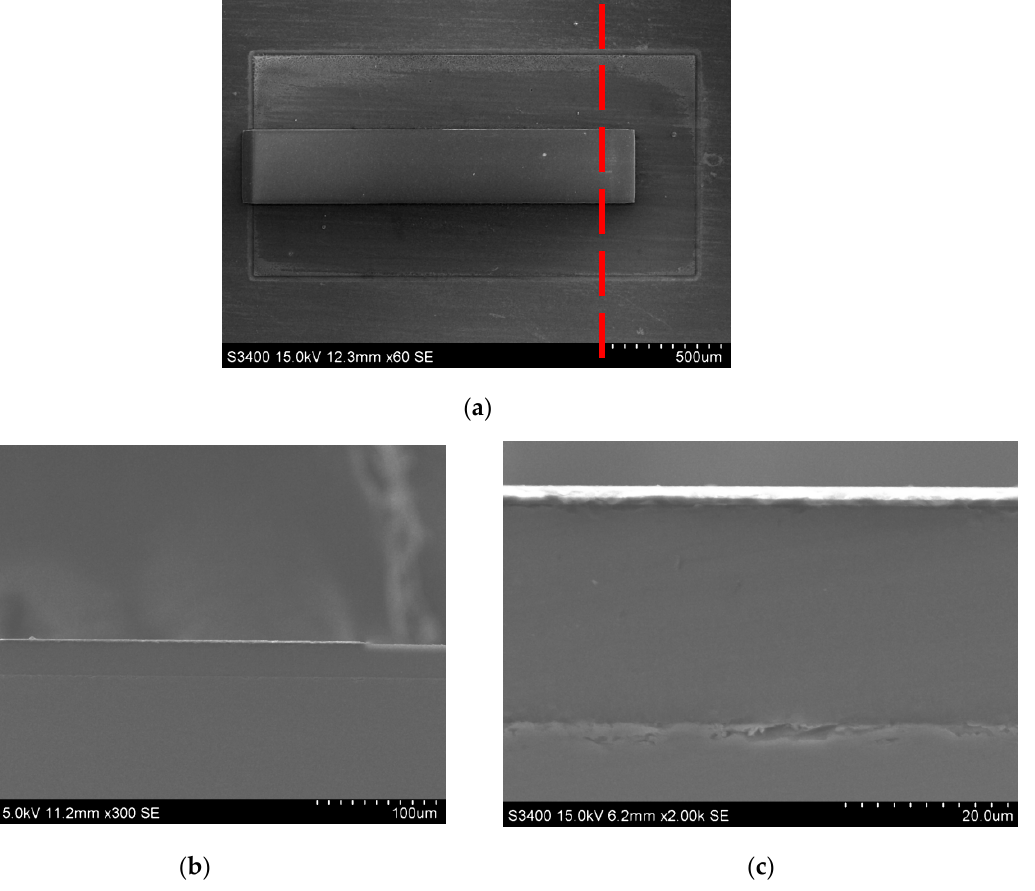
Figure 5. Preparation of porous silicon microstructure. ( a ) Top view. ( b ) Sectional view (overall). ( c ) Sectional view (partial).